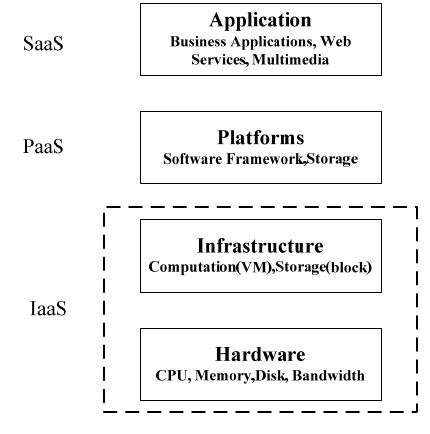
Figure2. The architechture of cloud computing The hardware layer: This layer is responsible for